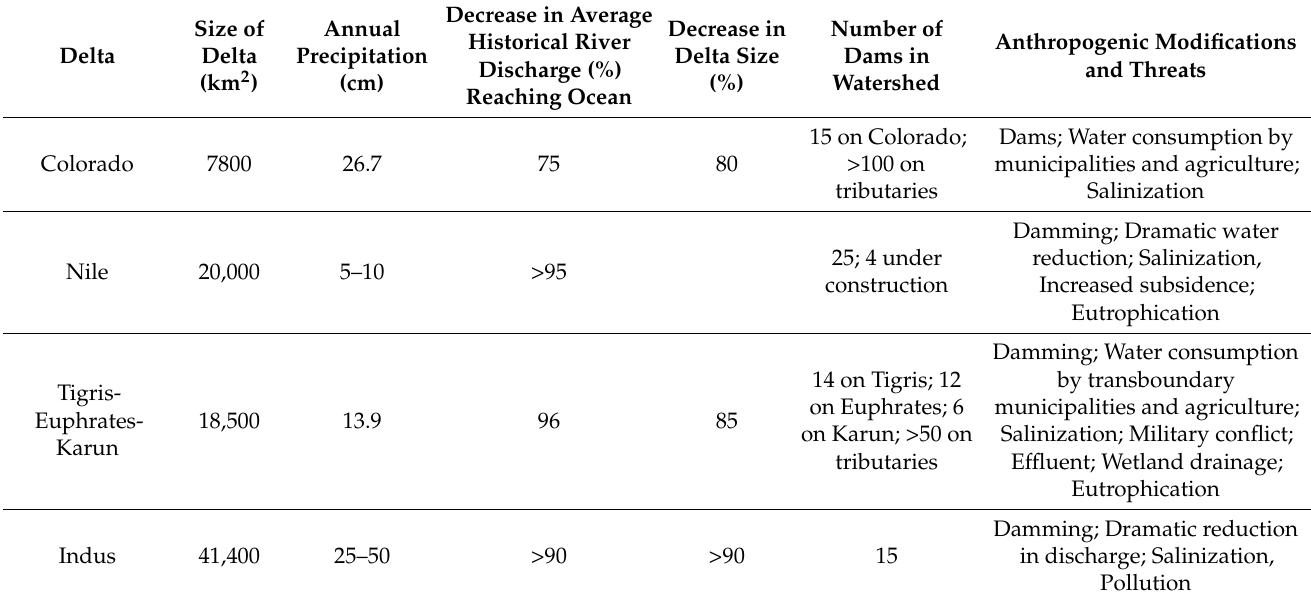
Table 1. Characteristics of arid